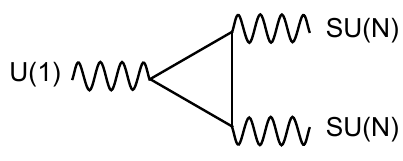
Figure 5 . The R-symmetry